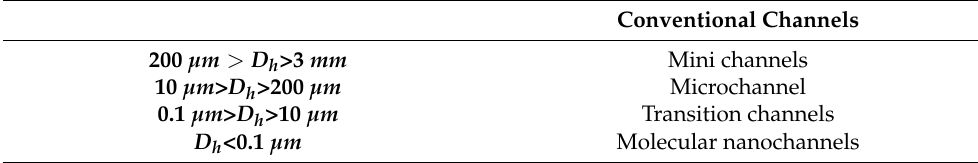
Table 2. A classification of channels based on hydraulic